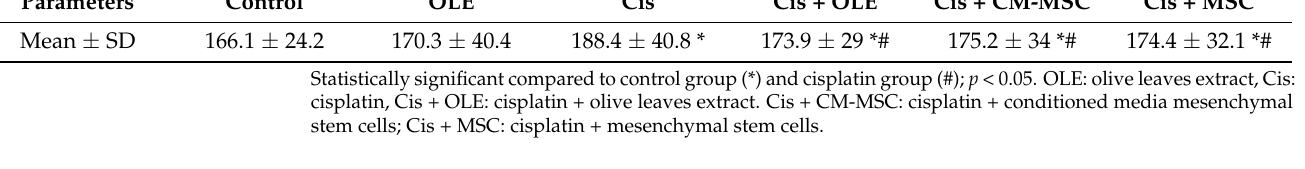
Table 8. The mean and standard deviation (SD) of the optical density of PCNA immunoreaction activity in the spleen in the different experimental groups.